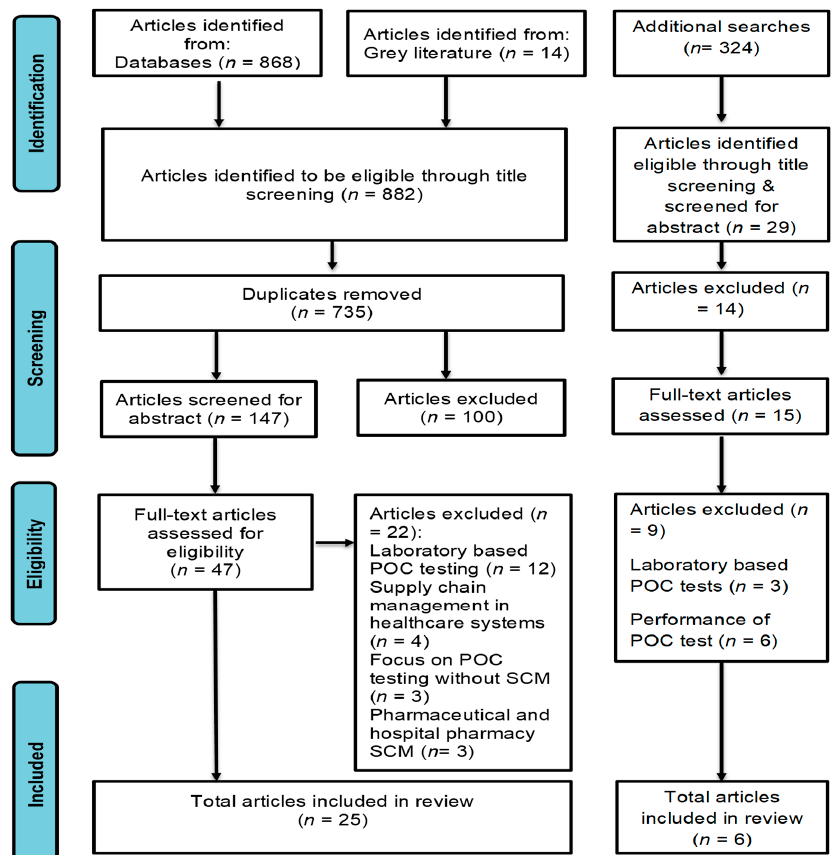
Figure 1. PRISMA-ScR flow chart showing the literature search and selection of articles.